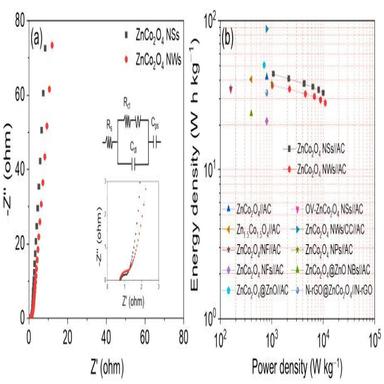
(a) The Nyquist plots of ZnCo2O4 NSs and ZnCo2O4 NWs, and the insets with the enlarged plots in the high-frequency region and the equivalent circuit, and (b) the Ragone plots of ZnCo2O4 NSs//AC HSC, ZnCo2O4 NWs//AC HSC, and some other similar HSCs reported earlier.